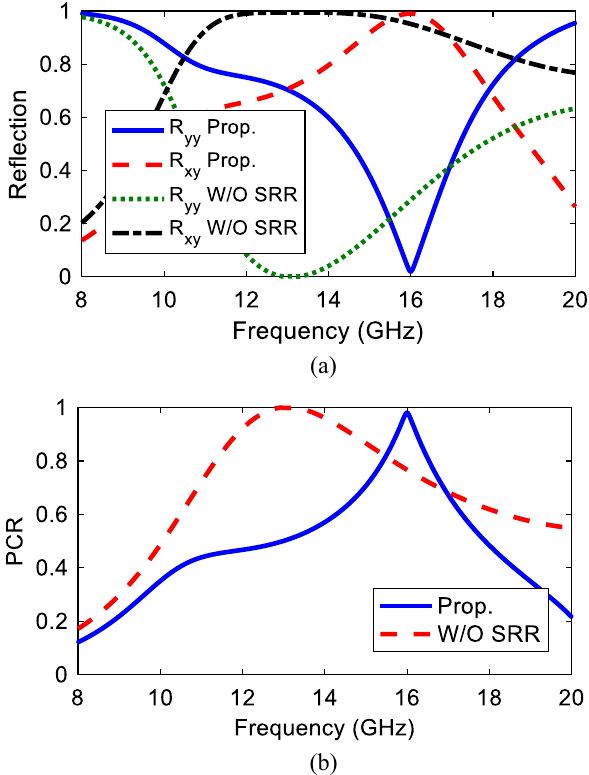
Figure 6. Structure with and without SRR ( a ) reflection magnitude, ( b )